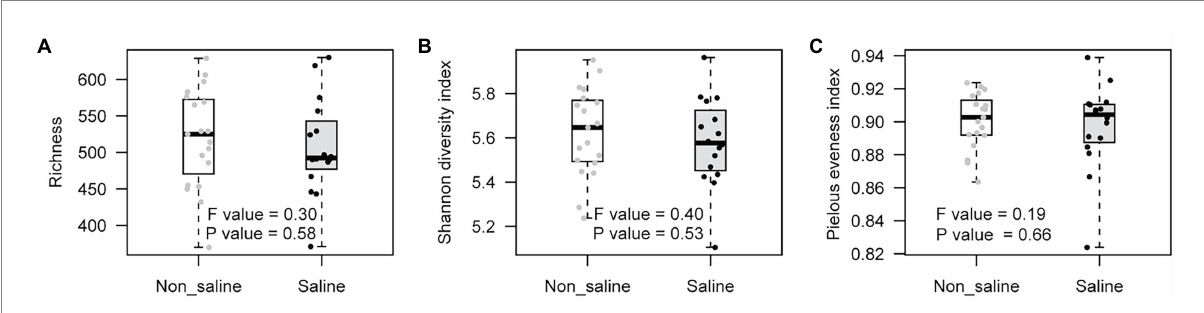
FIGURE 1 Box-plot of bacterial diversity in soil under non-saline water and saline groundwater irrigation. (A) Richness, (B) Shannon diversity index, and (C) Pielou’s evenness